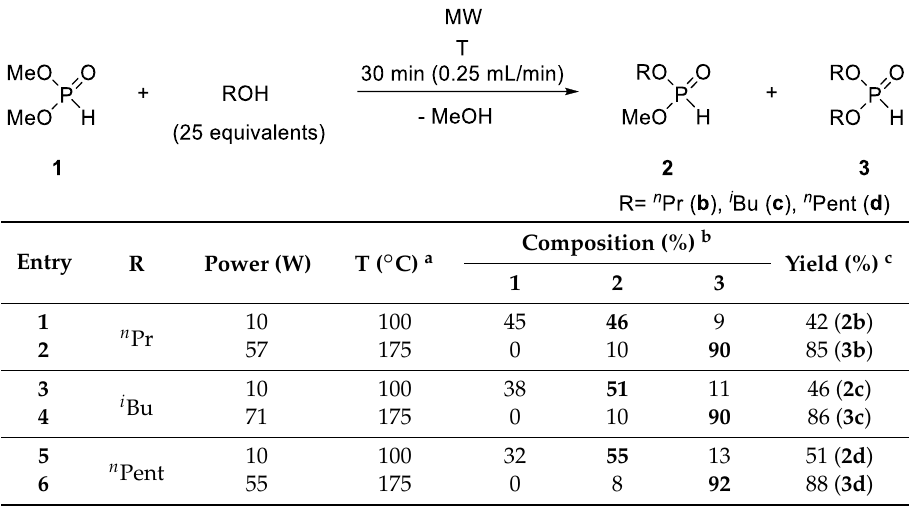
Table 5. Continuous flow alcoholysis of DMP with various alcohols.